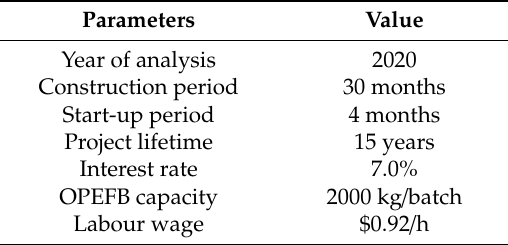
Table 2. Assigned terms for hand sanitiser plant’s economic evaluation.